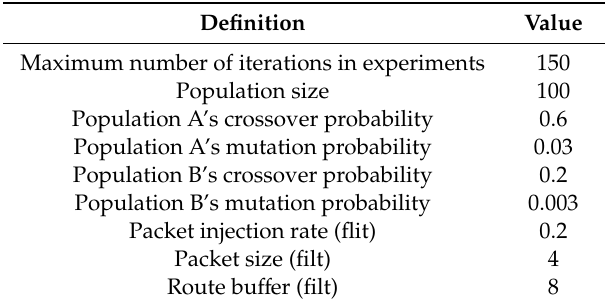
Table 5. Experimental parameter